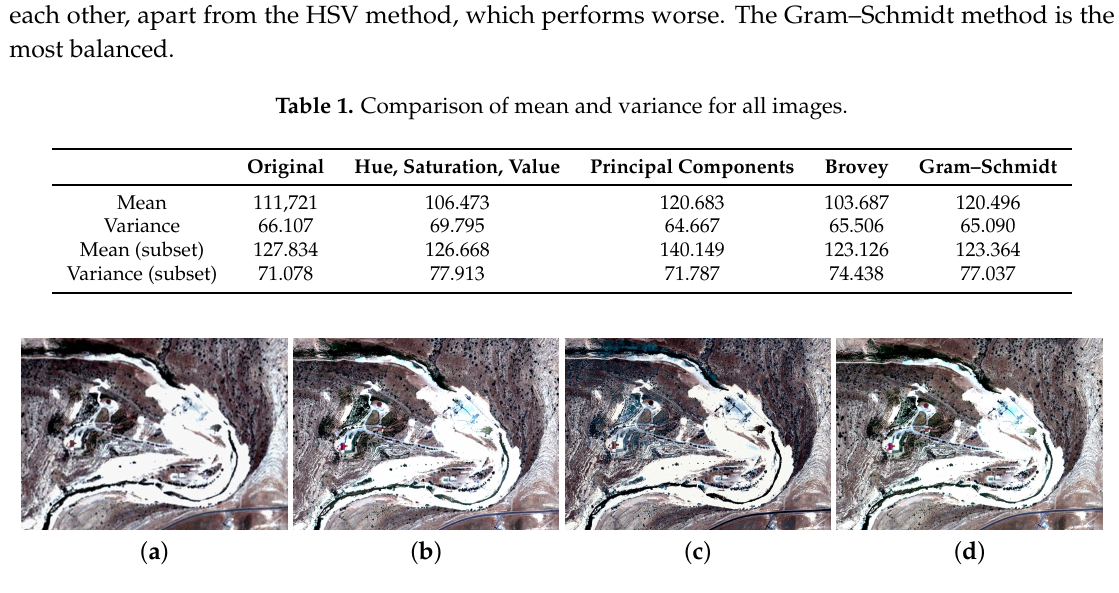
Figure 5. A comparison of the different pansharpening algorithms. The details show the area of the quarry since it is meaningful to evaluate the performances of the test. ( a ) HSV; ( b ) PC; ( c ) Brovey; ( d )